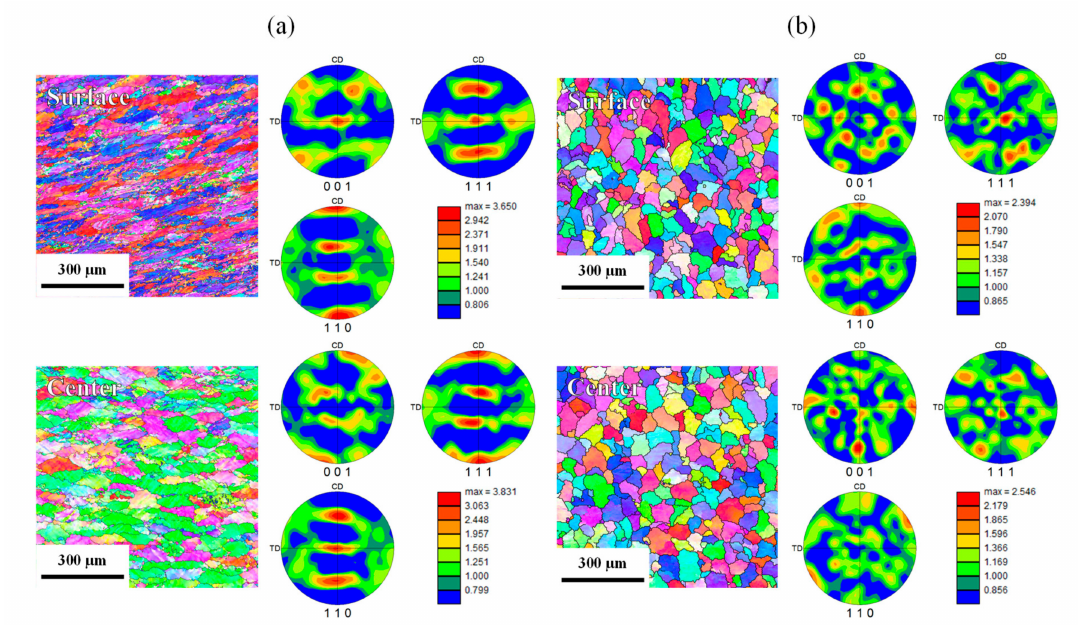
Figure 1. Inverse pole figure (IPF) maps and pole figures (PFs) of twin-roll cast strips fabricated at casting speeds of ( a ) 0.8 m / min, and ( b ) 5 m /